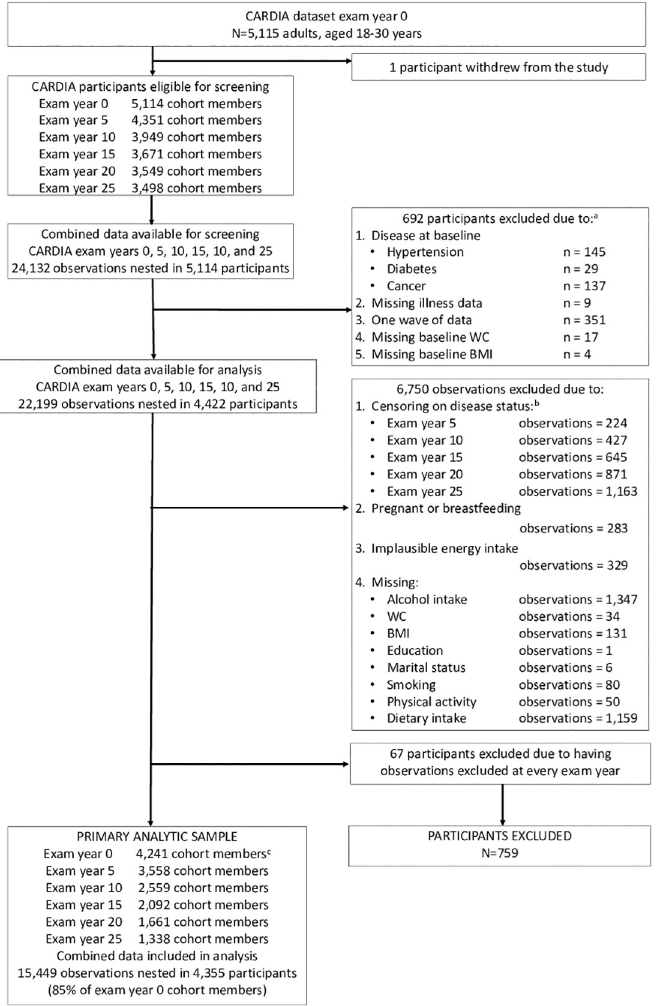
Fig 1. STROBE flow diagram of study participant inclusion and exclusion criteria. a Participants (n). b Observations censored for participants with diabetes, hypertension or self-reported cancer during follow-up at the year in which the disease was reported. c 114 participants included in the final analytic sample had excluded observations at exam year